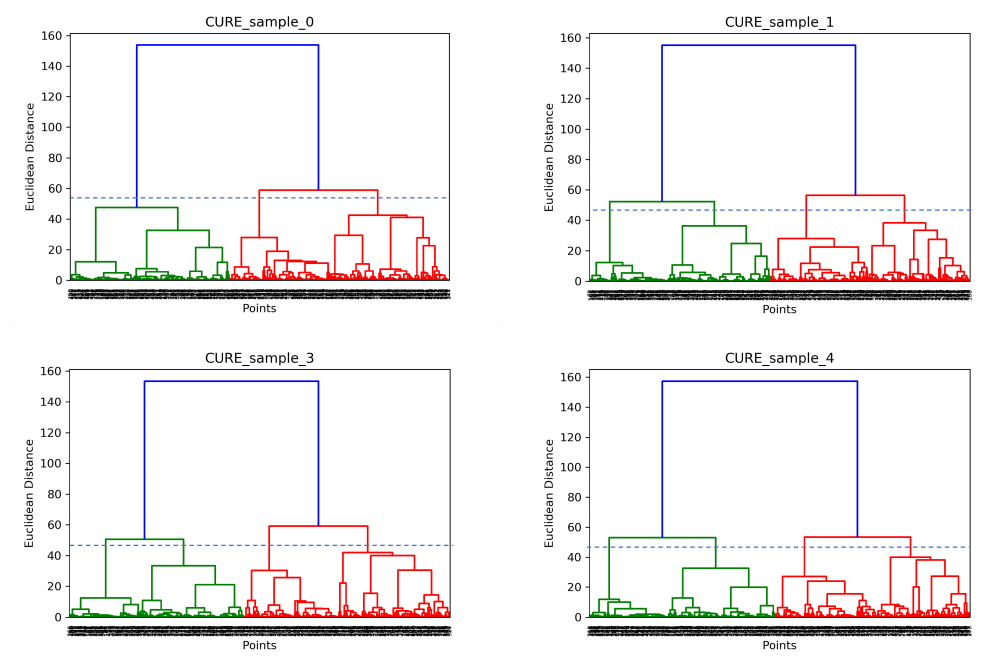
Figure 6. Sample dendrograms in bootstrap